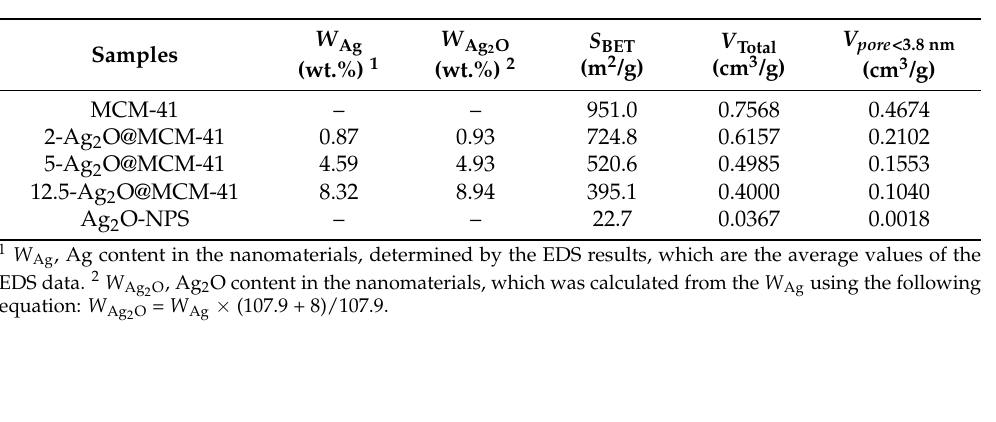
Table 1. The Ag 2 O contents and the textural parameters of different